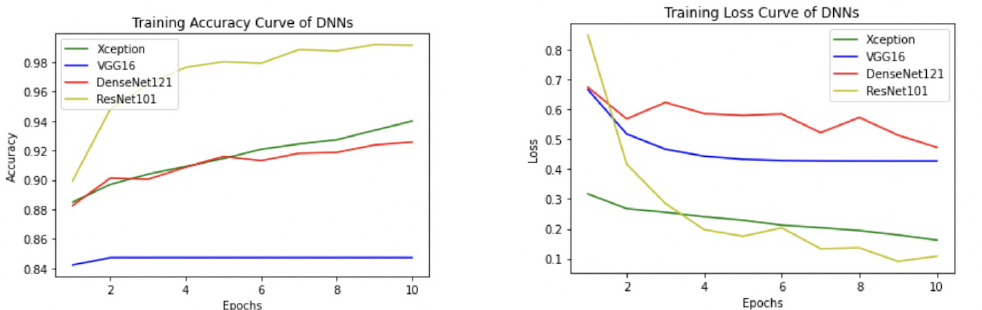
Figure 10. Average training accuracy and loss of 5 folds for the WSI dataset.